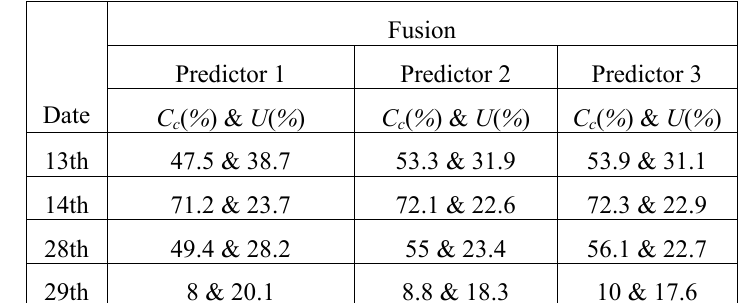
Table 3. Correct rate of cloud prediction (Cc) and unknown rate (U) for fused sensors with different